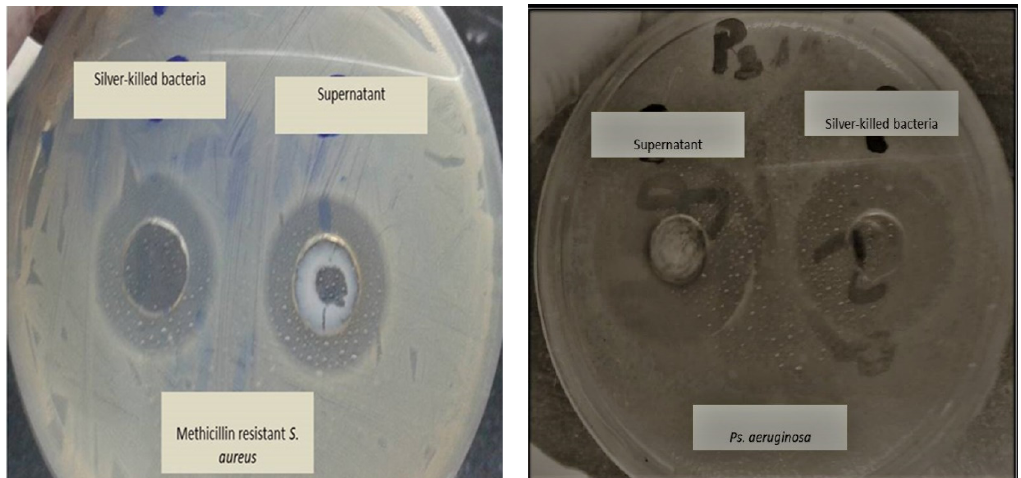
Figure 4. Antimicrobial activity of Silver treated bacteria (killed bacteria and the supernatant) on Ps. aeruginosa and Methicillin resistant Staph. aureus (MRSA) using well agar diffusion method. No significant difference between inhibition zone diameters obtained by killed bacteria suspension and supernatant.